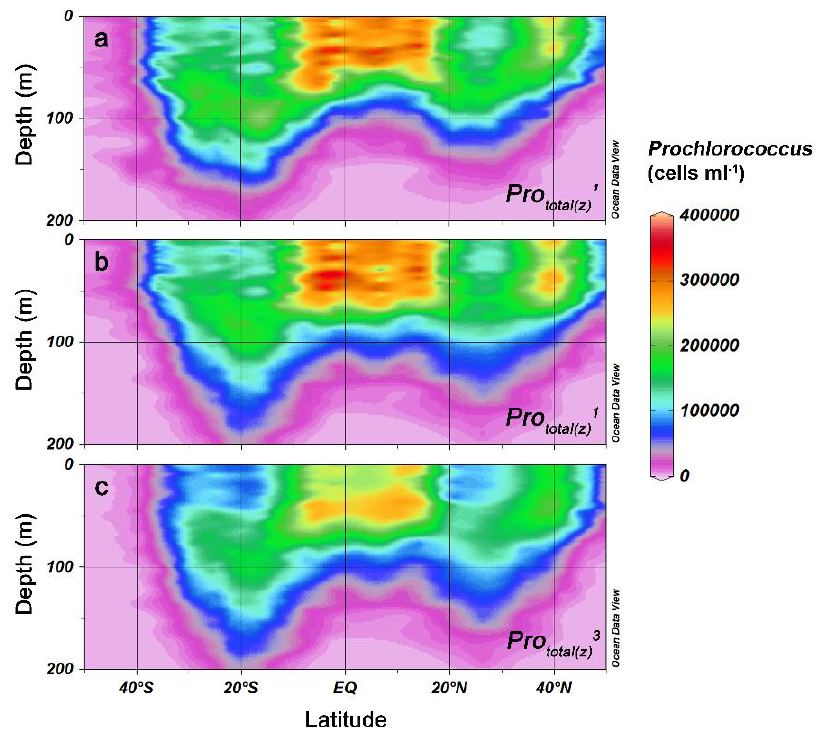
Figure 5. Vertical profiles of Prochlorococcus cell abundance over depth ( Pro total ( z )) across the Atlantic Ocean (locations displayed in Figure 1): ( a ) observed in situ on AMTs 12 – 24 ( Pro total ( z ) ′ ); ( b ) predicted using the partial model with observed inputs of Pro surf and Z DCM ( Pro total ( z ) 1 from Equations (1) to (2) and (6) to (7)); and ( c ) predicted using the full model with remote-sensing inputs ( Pro total ( z ) 3 from Equations (1) – (9).